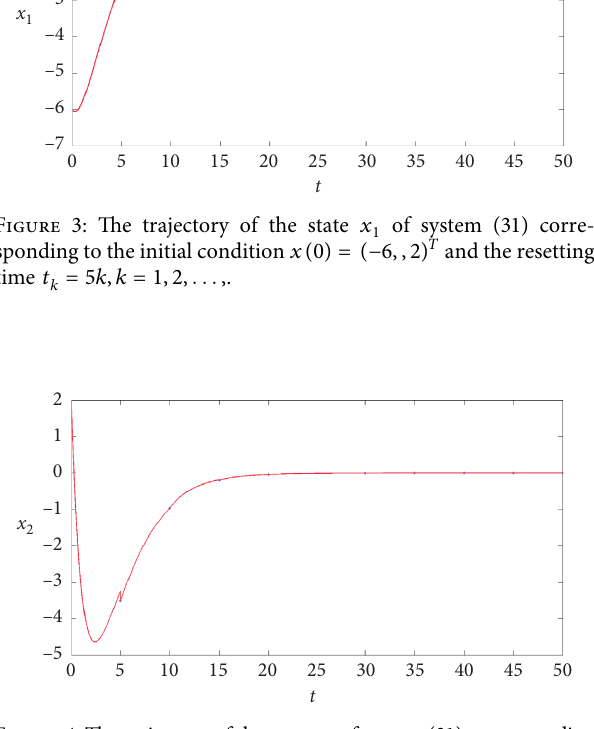
of system (31) corresponding 2